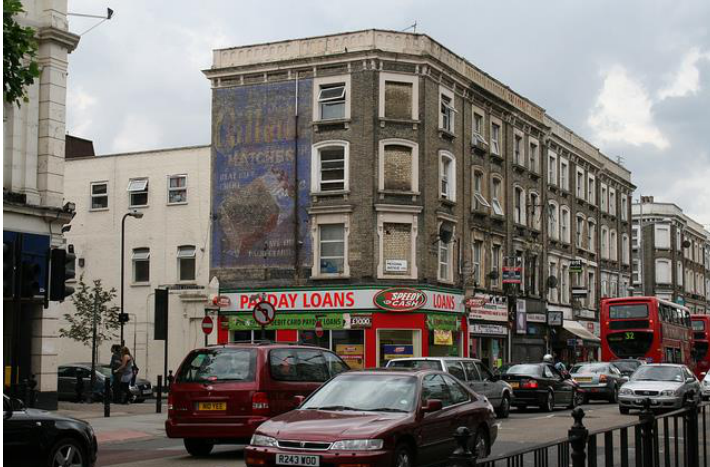
Figure 4. A panorama of KHR shopfronts. Source: Flickr, The Creative Commons.